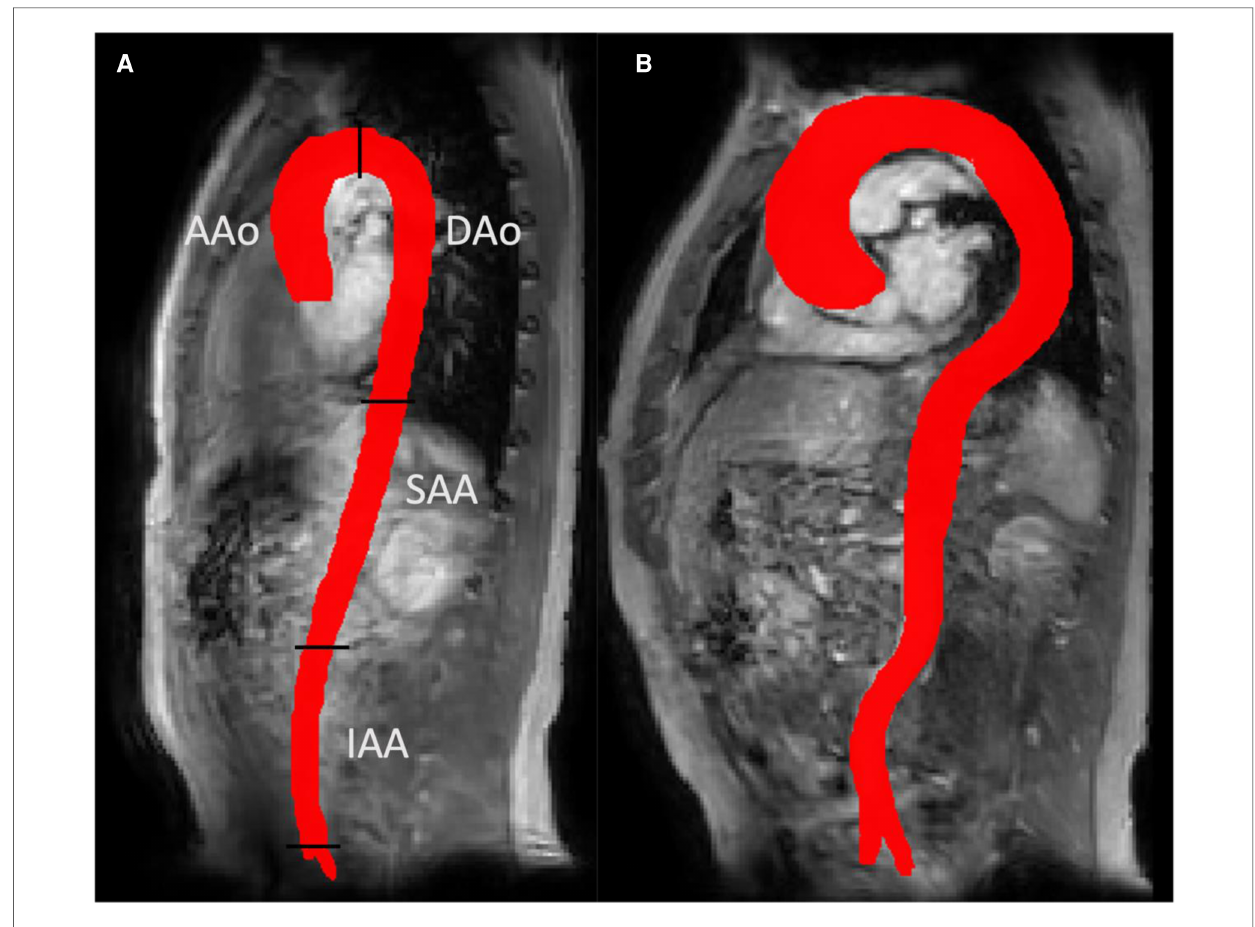
FIGURE 2 3D aortic segmentations for a representative young subject (panel a) and an old subject (panel b). A more tortuous aorta can be seen in the old subject. Panel a also shows the four aortic segments used for regional analysis in this study: ascending aorta (AAo), descending aorta (DAo), suprarenal and infrarenal abdominal aorta (SAA and